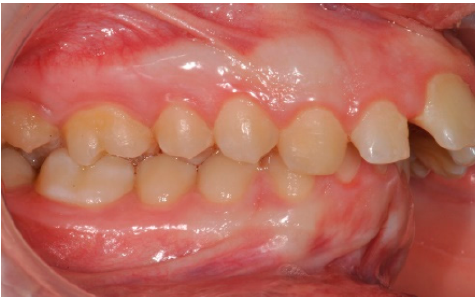
Figure 2. Lower anterior segments.